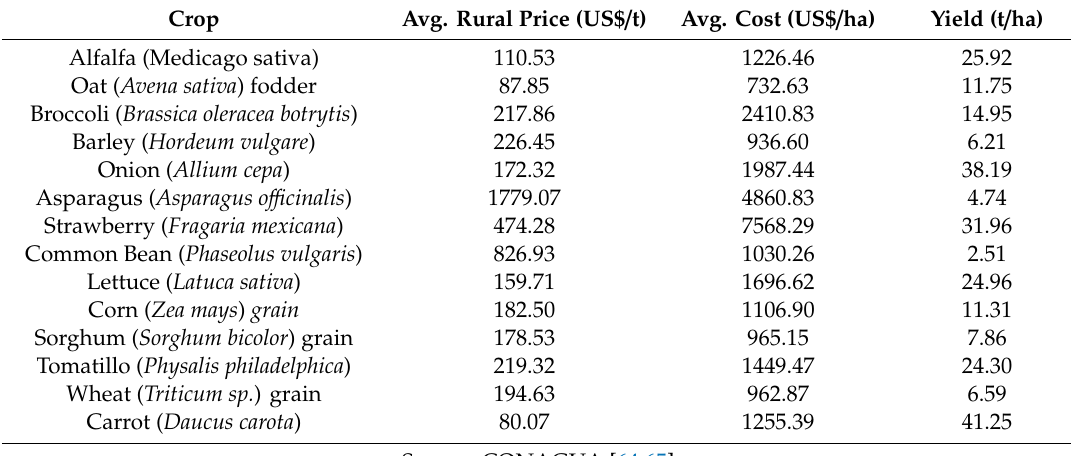
Table 2. Average rural prices, costs, and yields of the 2014–2015 to 2016–2017 agricultural years in Irrigation District